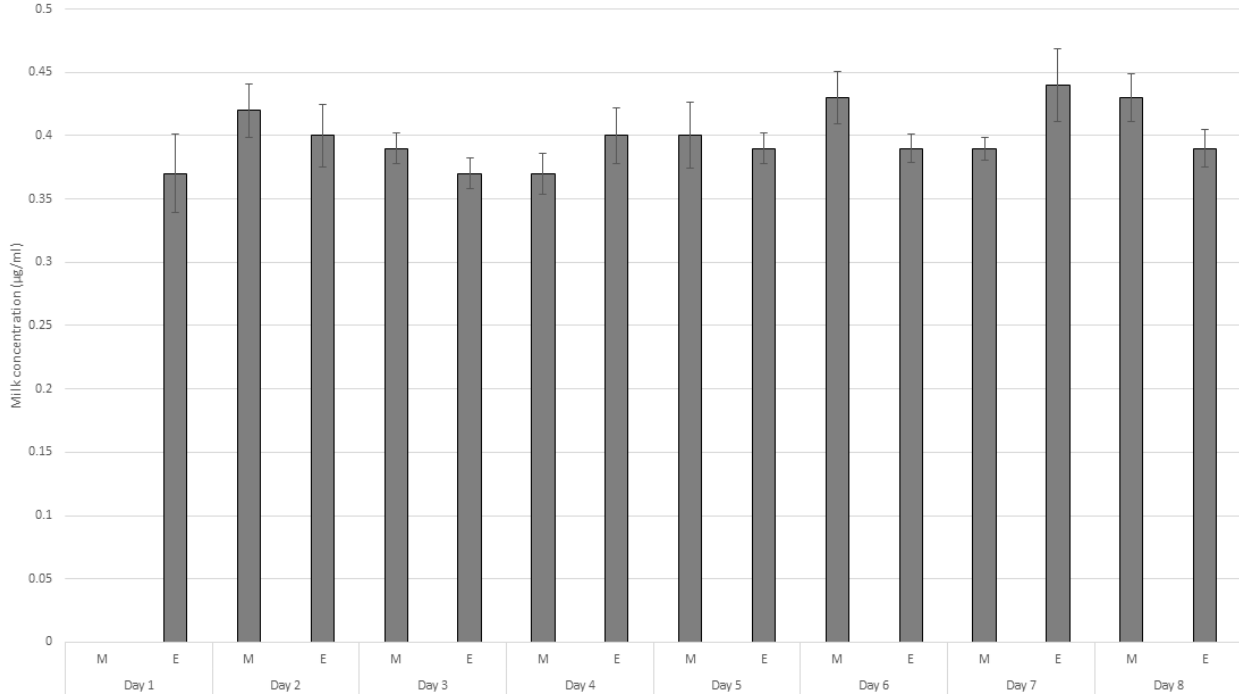
Figure 4. Plot of the mean concentration of amitraz in milk collected twice daily in the morning and evening up to eight days after single dermal administration ( n = 6, mean ± SE values; M = morning, E = evening).